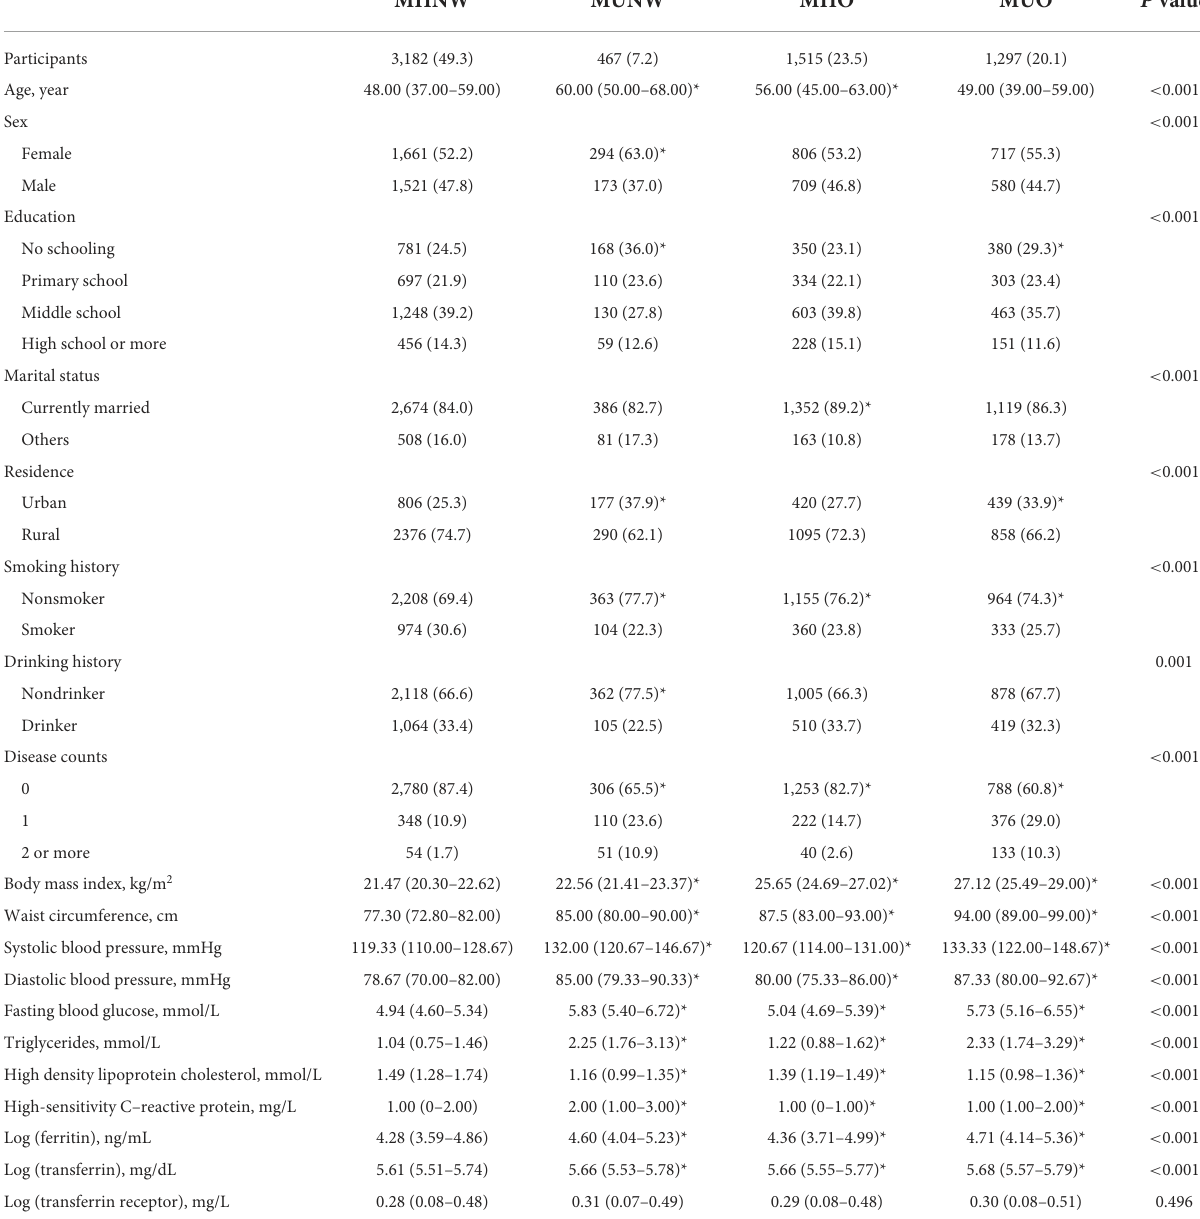
TABLE 1 Basic characteristics of study participants in the CHNS 2009 ( N =